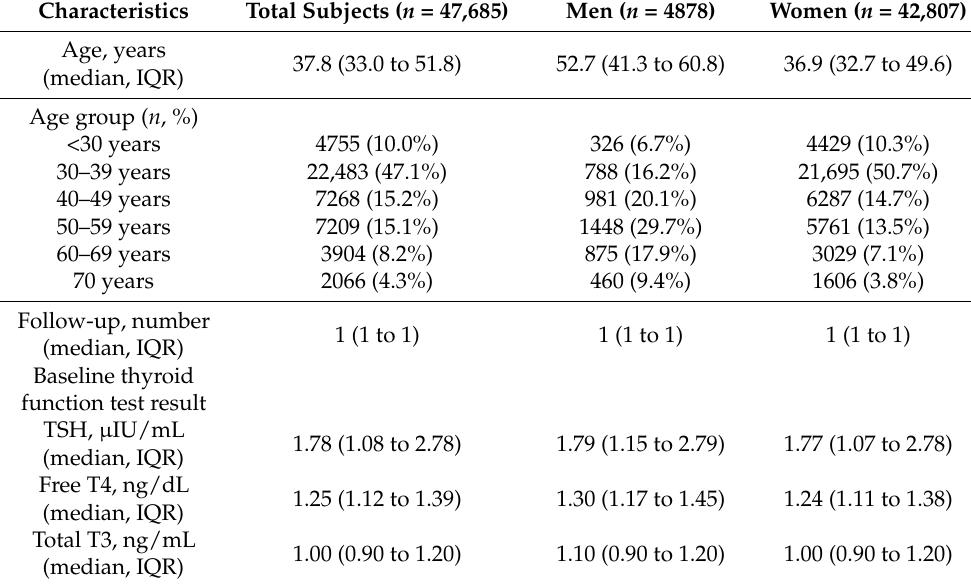
Table 1. Baseline characteristics of 47,685 study